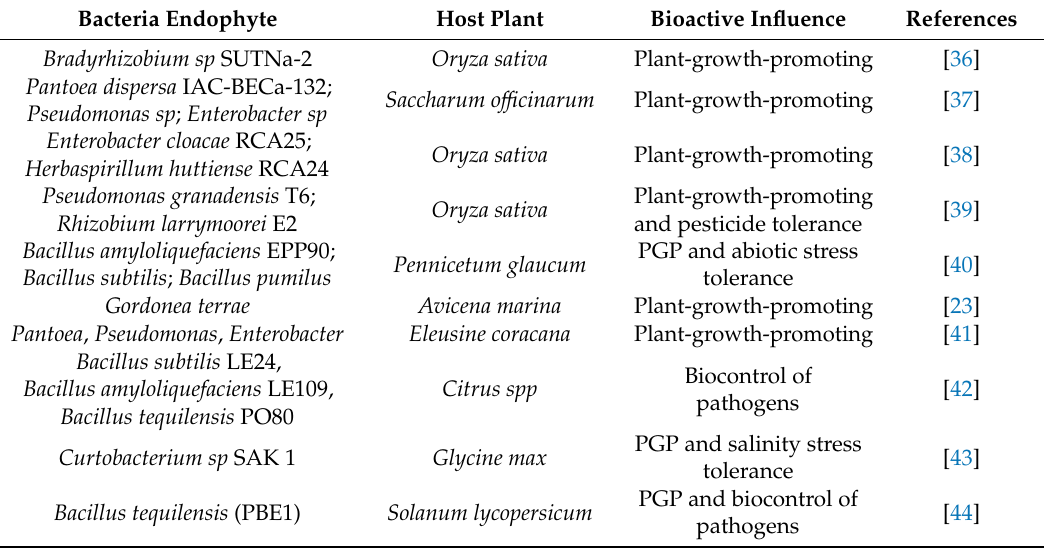
Table 1. Plant productivity improvement using bacterial